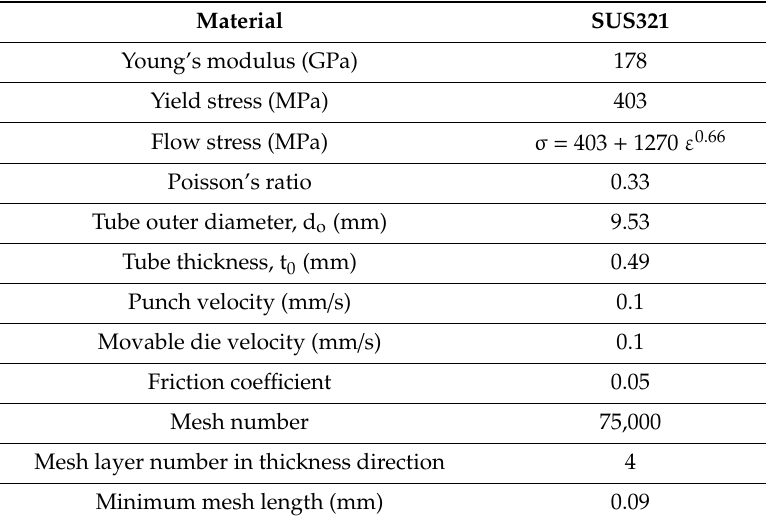
Table 1. Forming parameters used in FE simulations.